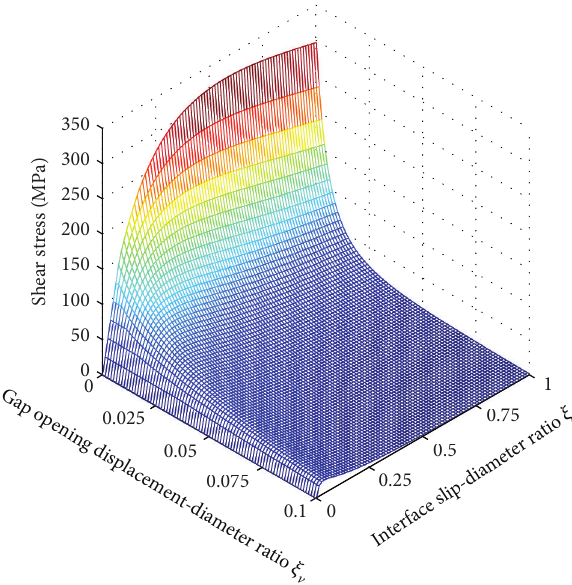
Figure 5: The space curved surface of 𝜉 𝑠 and 𝜉 V to shear stress of single steel bar.